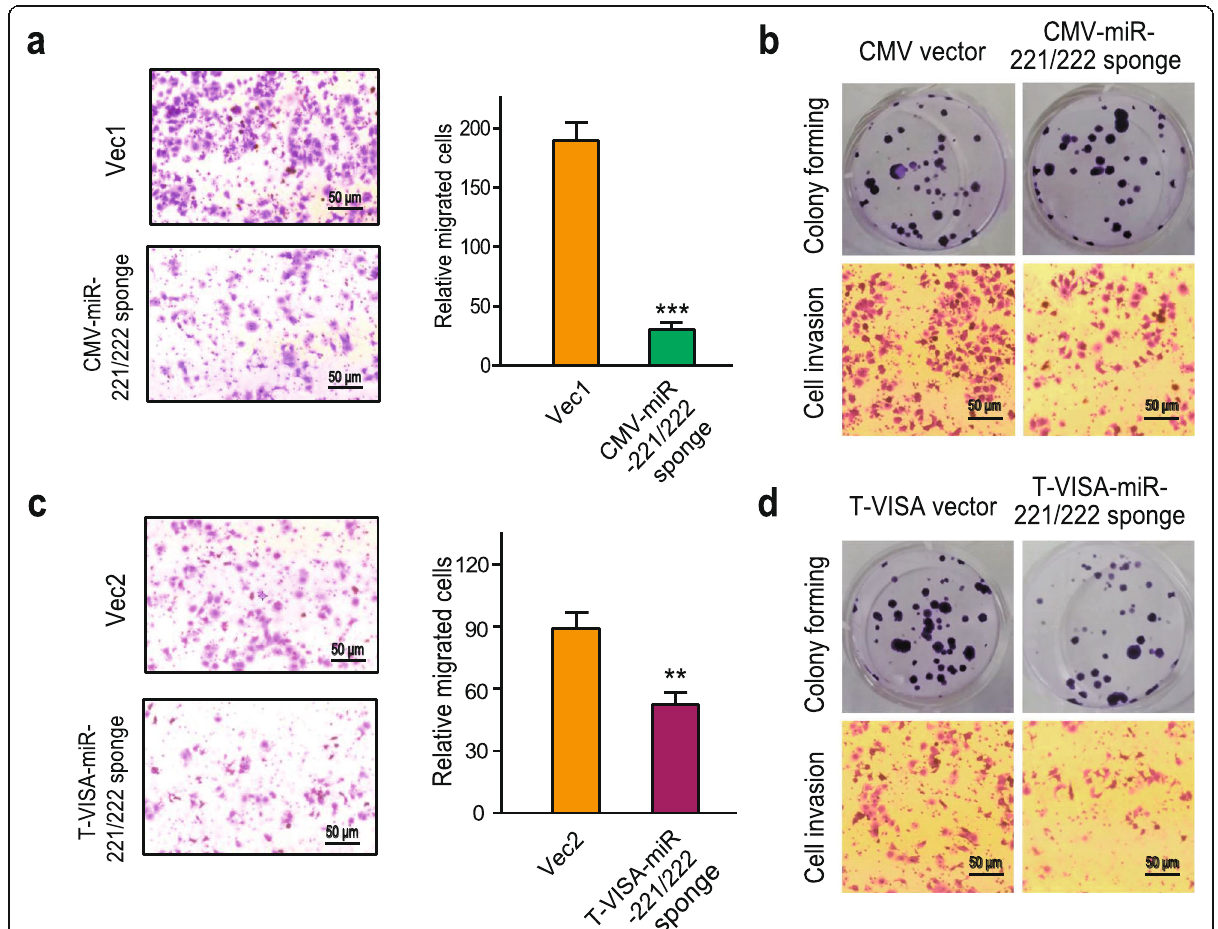
Fig. 5 The CMV-miR-221/222 sponge and T-VISA miR-221/222 sponge inhibited tumor progression in MCF-7 TamR cells. MCF-7 TamR cells were transfected with the miR-221/222 sponge expressing vectors or corresponding control vectors. The effects of the miR-221/222 sponge on cell migration of MCF-7 TamR cells were determined by the transwell assay ( a , c ), and the colony numbers and the cell invasion of MCF-7TamR cells were determined by cell colony-forming assay and the transwell assay, respectively ( b , d ). *** p < 0.001, ** p <